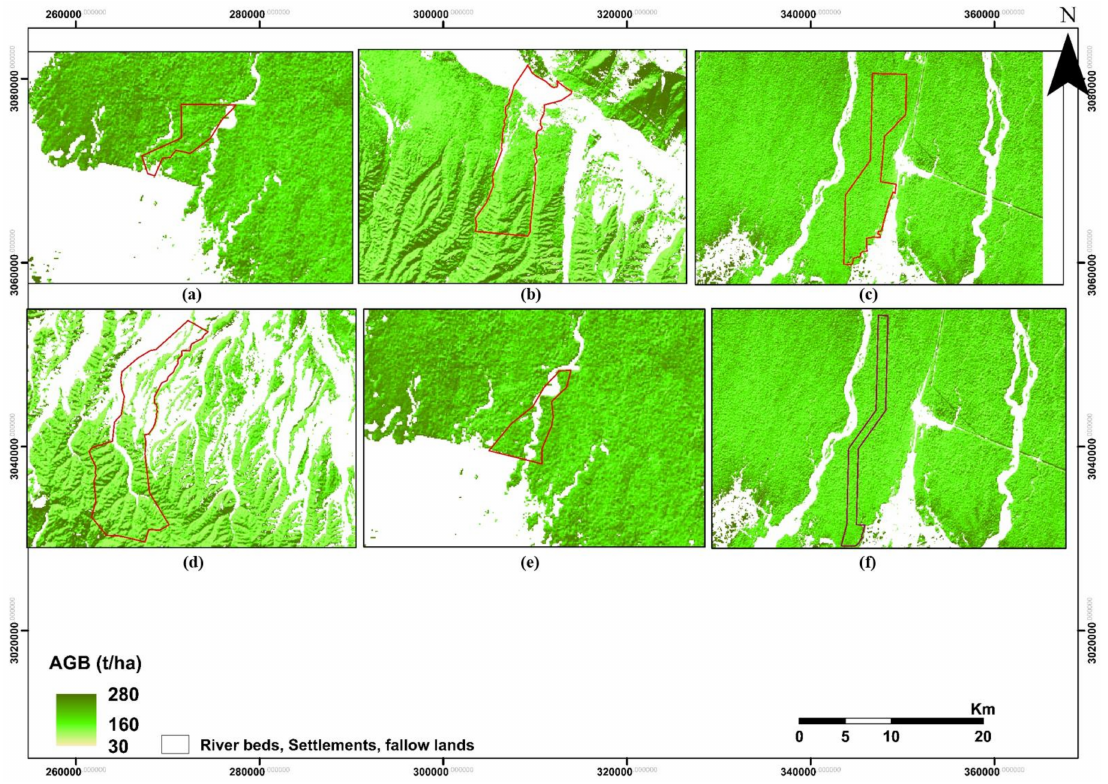
Figure 5. Above ground biomass of six community forests using the RF algorithm. ( a ) Ratomate BZCF, ( b ) Jyamire BZCF, ( c ) Radha Krishna BZCF, ( d ) Janahit BZCF, ( e ) Shrijana BZCF, and ( f ) Mushaharnimae